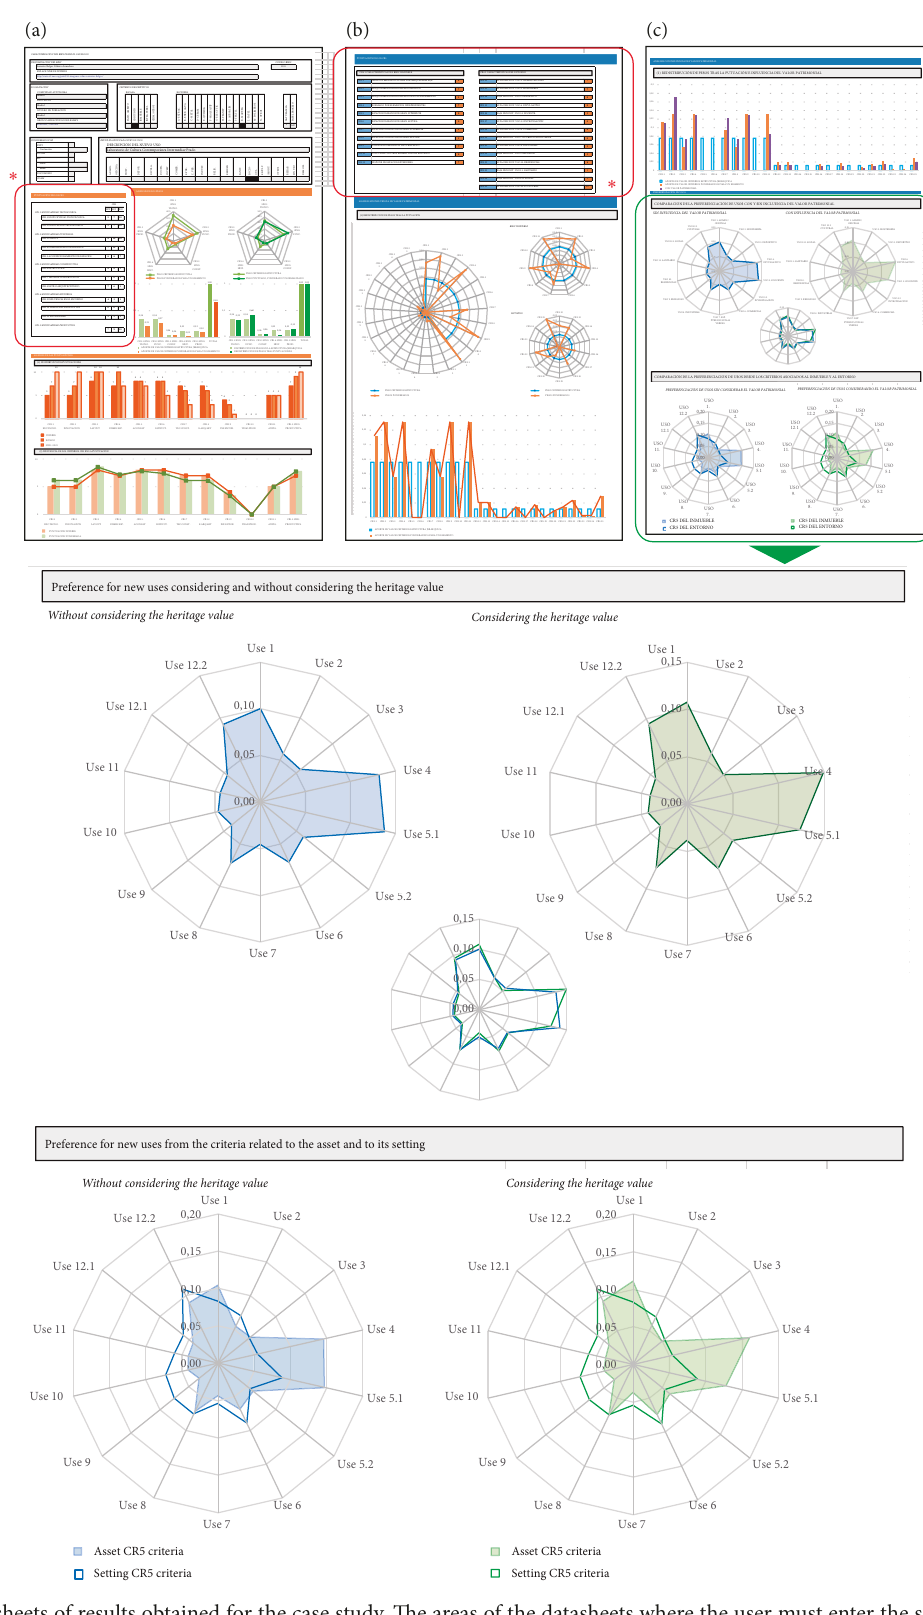
Figure 10: Datasheets of results obtained for the case study. The areas of the datasheets where the user must enter the scores requested are highlighted in red and marked with an